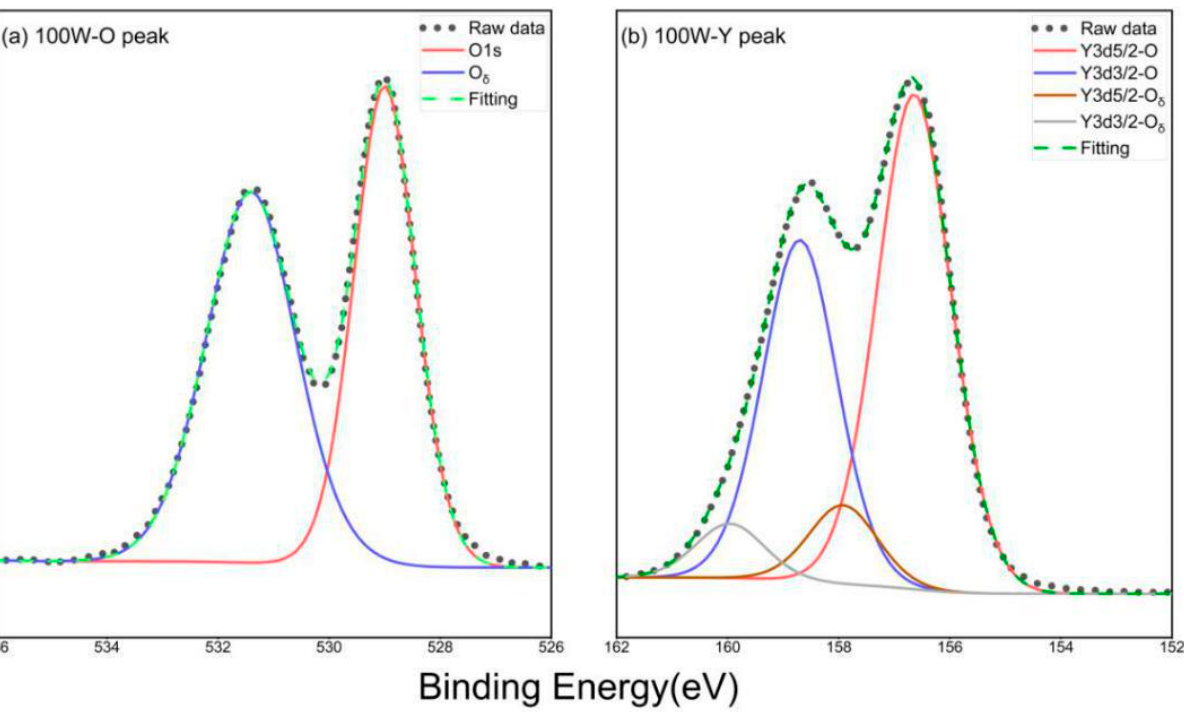
Figure 3. The XPS spectra of ( a ) the O1s core level and ( b ) the Y3d core level of the as-deposited Y 2 O 3 thin film (samples 1–3).